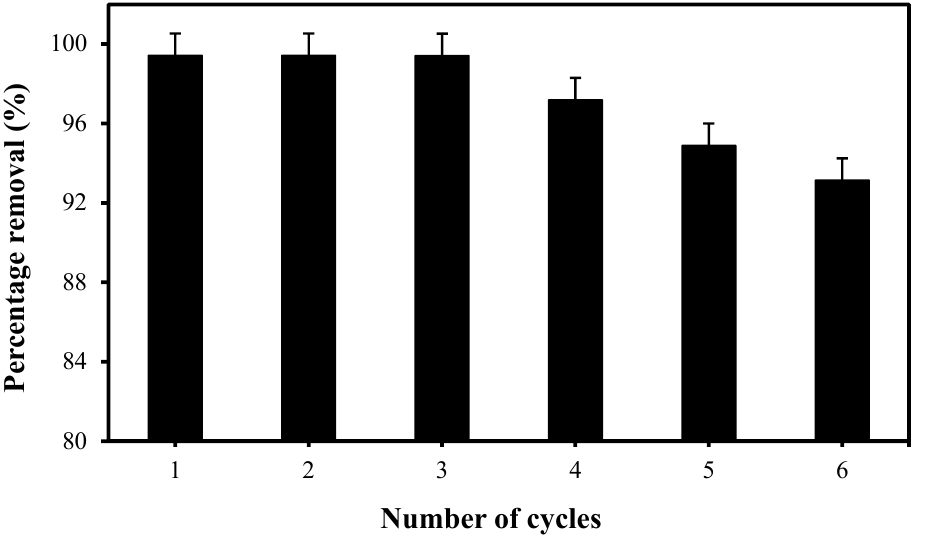
Figure 7. Reusability of MIL-101(Cr) adsorbent.